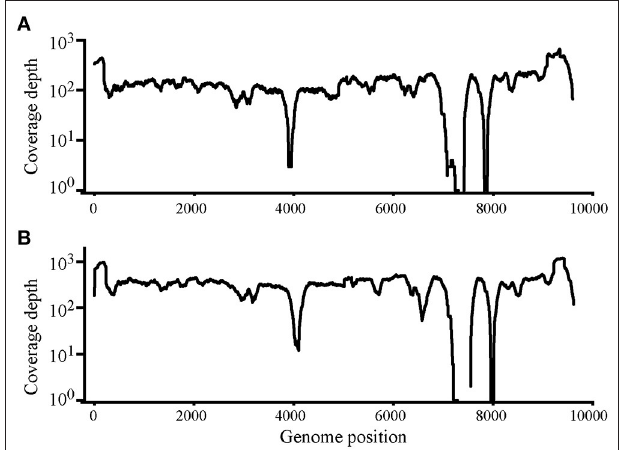
FIGURE 2 | Read depth analysis of Chinese Visna/Maedi virus strains CMV-1 (A) and XM-MDV30 (B) using Illumina Sequencing reads. Coverage of each position on the VMV genome is indicated on the y axis with a log 10 scale. The x -axis indicates the genome position on the VMV genome.